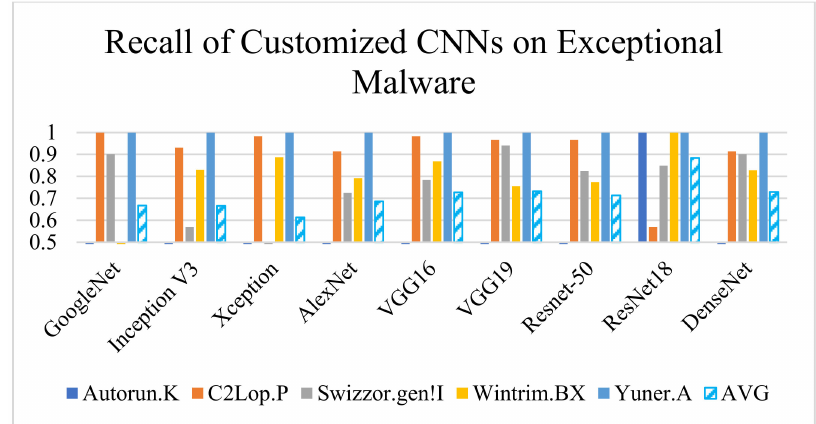
Figure 9. Performance (recall) comparison of implemented CNN models.